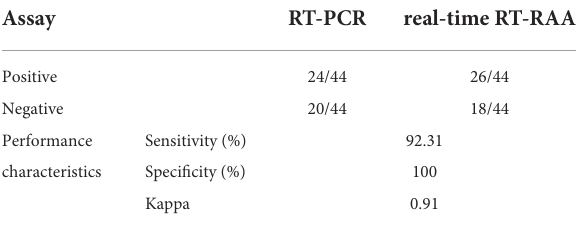
TABLE 4 Performance of the real-time RT-RAA assay compared to the reference method, RT-PCR, for detecting ALV in clinical samples. Assay RT-PCR real-time